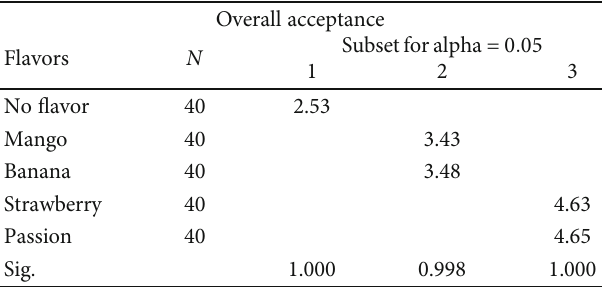
Means for the groups in homogeneous subsets are FFA values for the three fractions were 2 : 16 ± 0 : 22 , 1 : 55 ± 0 : 14 , and 2 : 71 ± 0 : 43 for the oil phase, emulsion phase, and the homogenate, respectively (Table 4). The FFA content was below the recommended values of 3% in all the samples.